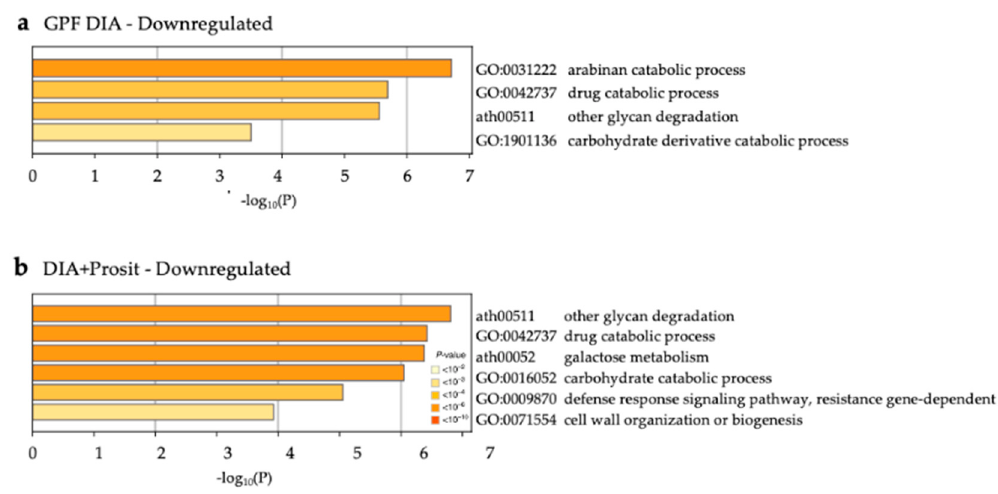
Figure 10. Decreased GO biological processes and KEGG pathways during Xf infection in V. vinifera . Non-redundant enriched ontology clusters of significantly expressed proteins decreased during Xf infection ( p < 0.05) in ( a ) GPF DIA and ( b ) DIA + Prosit data sets. Similarly to Figure 9, DIA + Prosit identified more pathways likely involved with plant response to infection.